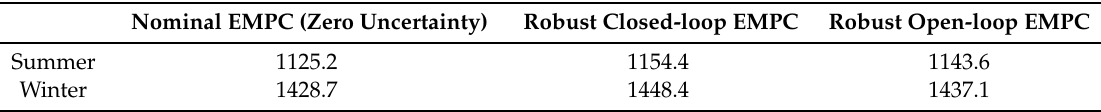
Table 2. Daily economic costs Case study 1.